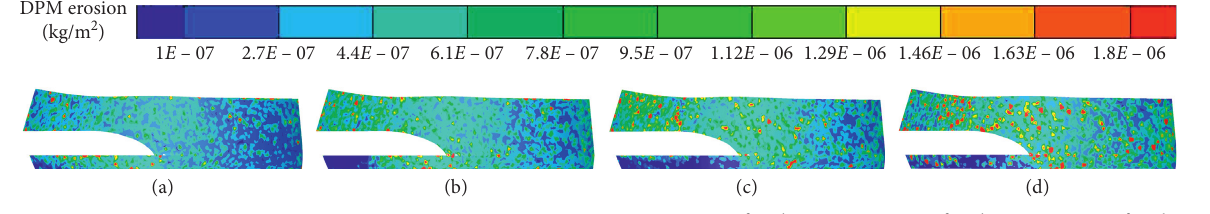
Figure 4: Pressure surface wear clouds at different flow rates. (a) Q � 9.6m 3 · h − 1 , (b) Q � 12.8m 3 · h − 1 , (c) Q � 16 m 3 · h − 1 , and (d) Q � 19.2m 3 · h − 1 .